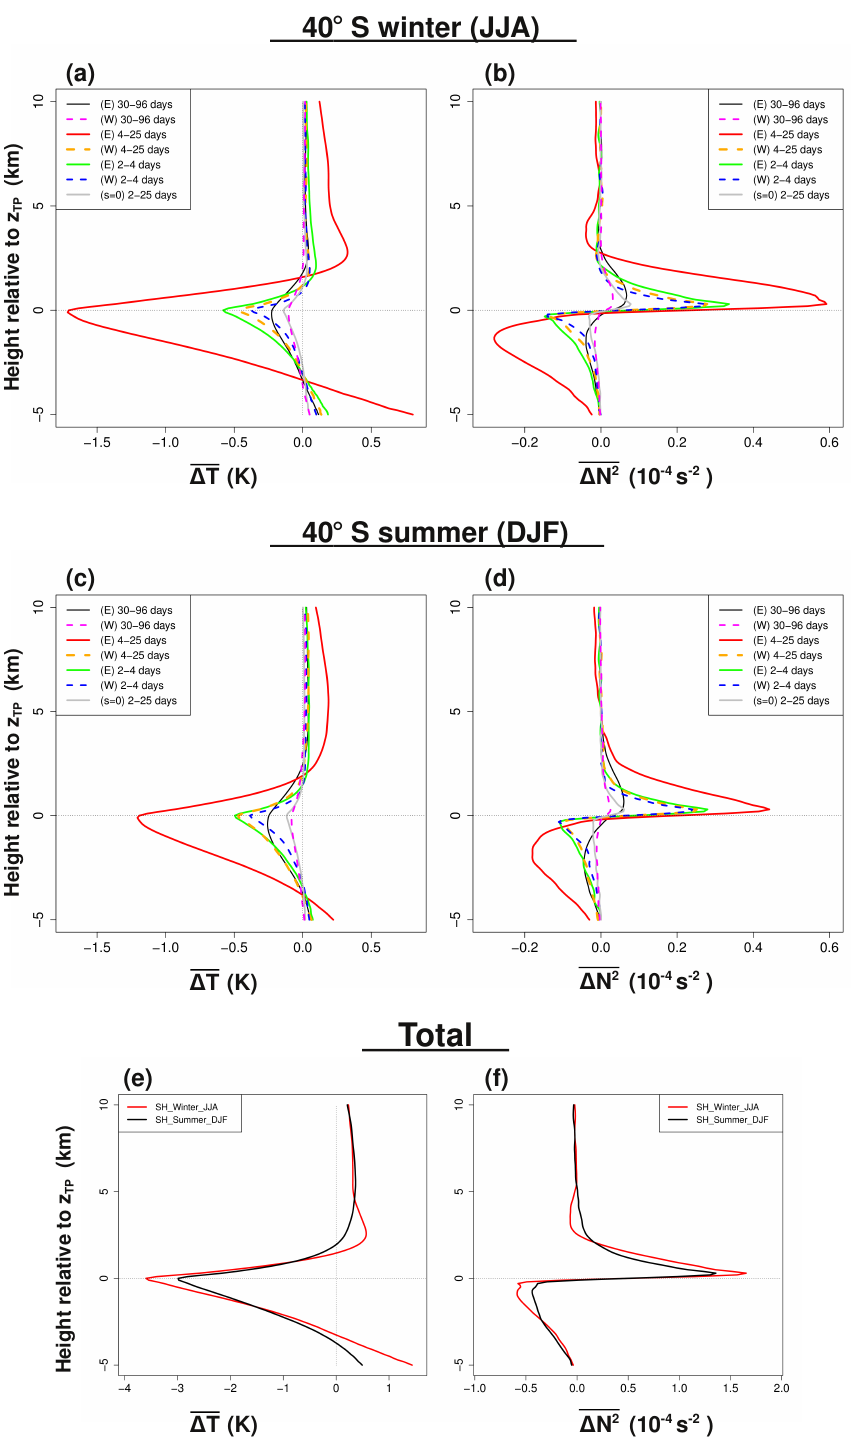
Figure A1. As in Figs. 4, 6 and 8, but for 40 ◦